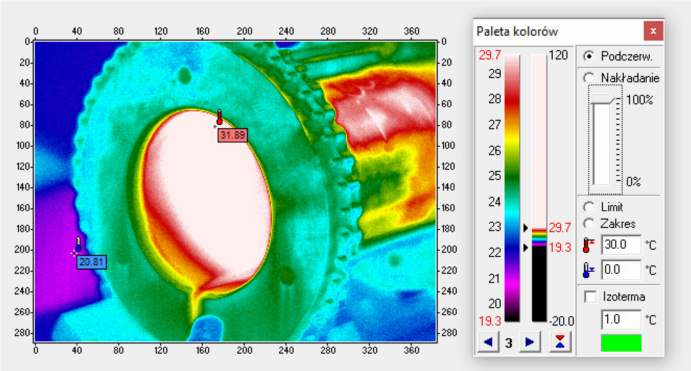
Figure 6. Image of a cylinder obtained with a thermal imaging